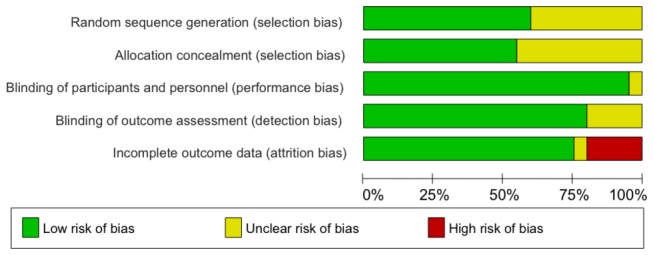
Risk of bias graph.